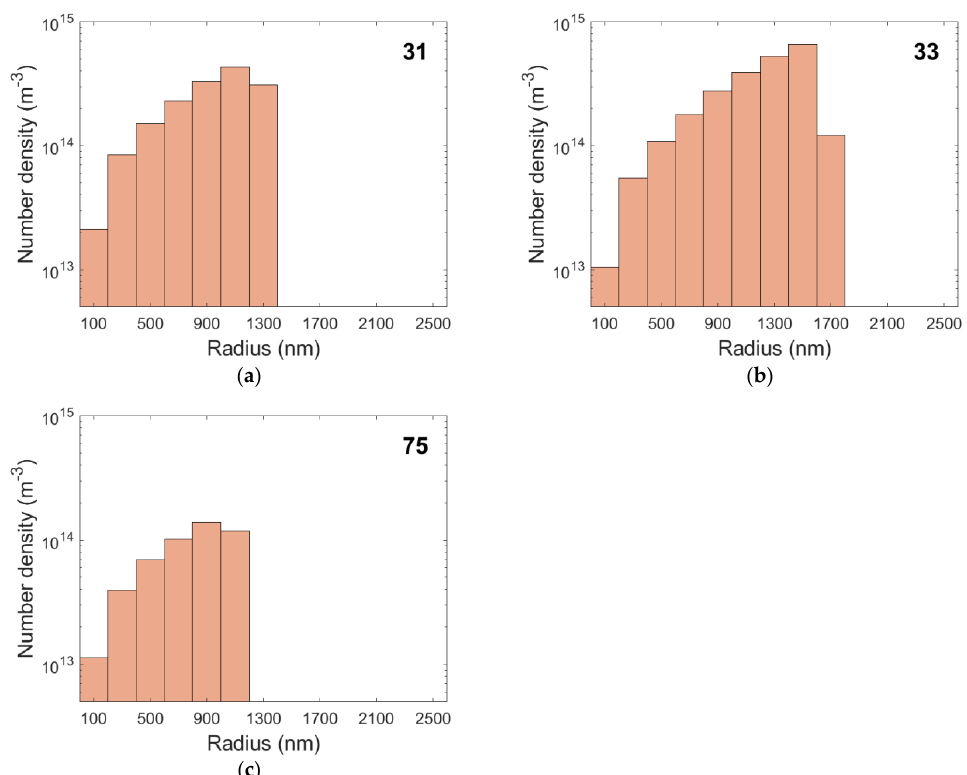
Figure 7. Simulated cavity radii vs. number density for the creep conditions of specimens 31 ( a ), 33 ( b ), and 75 ( c ).